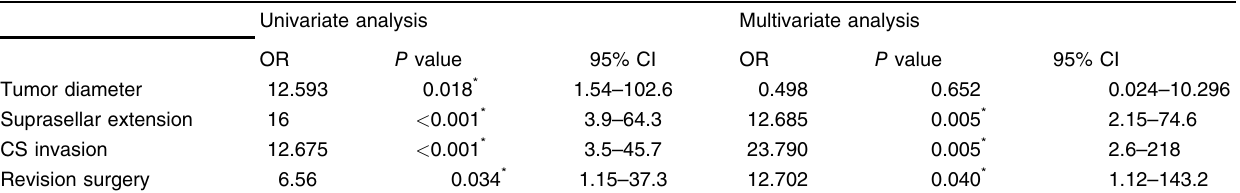
Table 5 Preoperative predictors for disease control in 65 pituitary adenoma patients